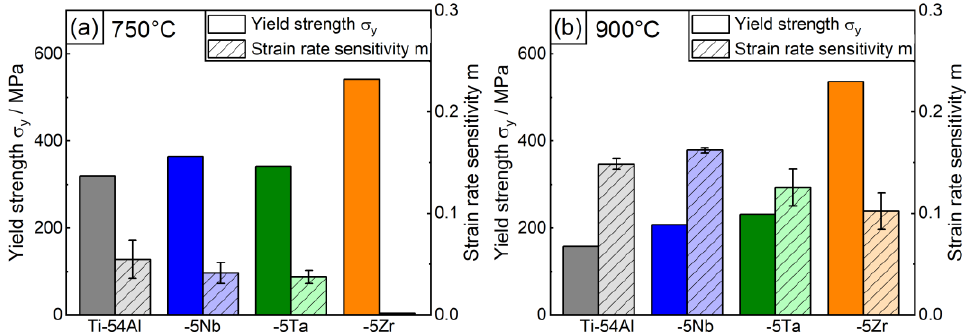
Figure 7. Strain rate sensitivity m and 0.2% compressive strength σ p 0.2 of the Ti-54Al-5X alloys and Ti-54Al at ( a ) 750 °C and ( b ) 900 °C.